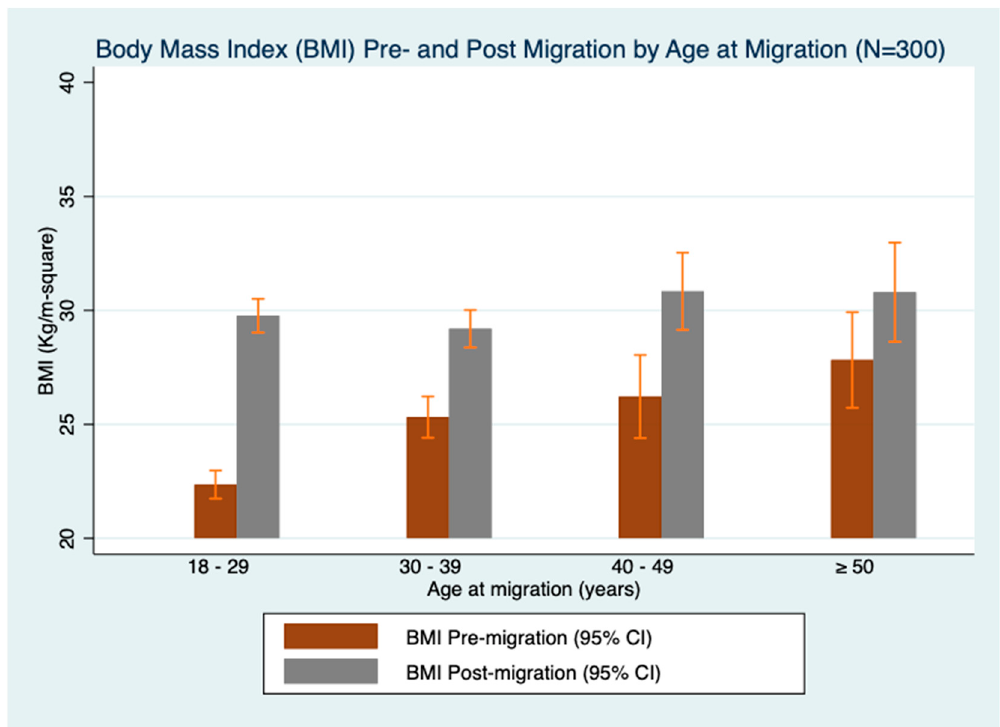
Figure 2. Body Mass Index pre- and post-migration to the US by age at migration.